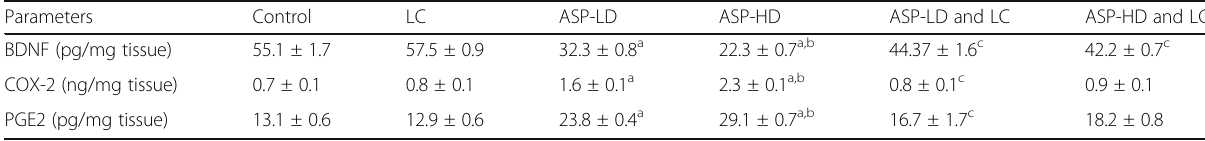
Table 2 Effect of L -carnitine on BDNF, COX-2, and PGE2 in the brain of male rats treated with aspartame